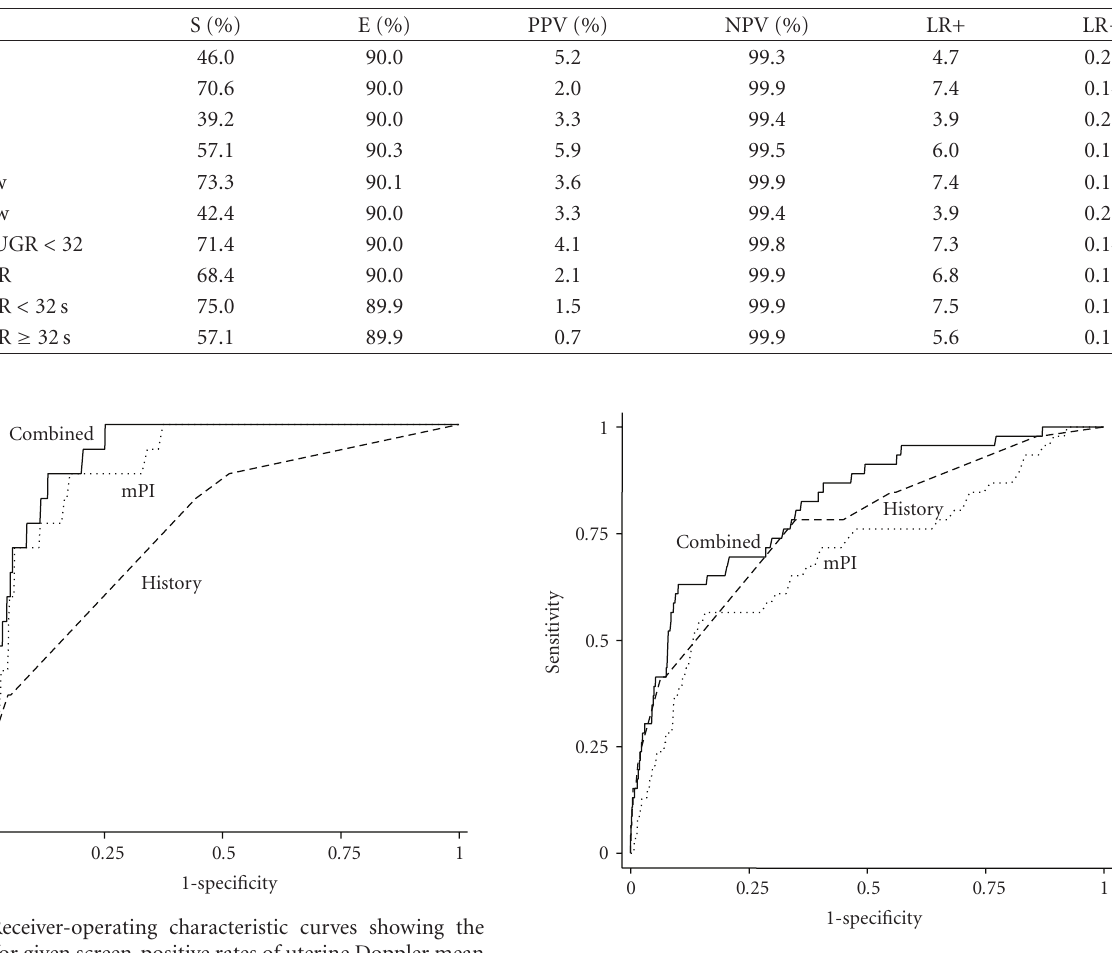
Figure 3: Receiver-operating characteristic curves showing the higher sensitivities for given screen-positive rates of uterine